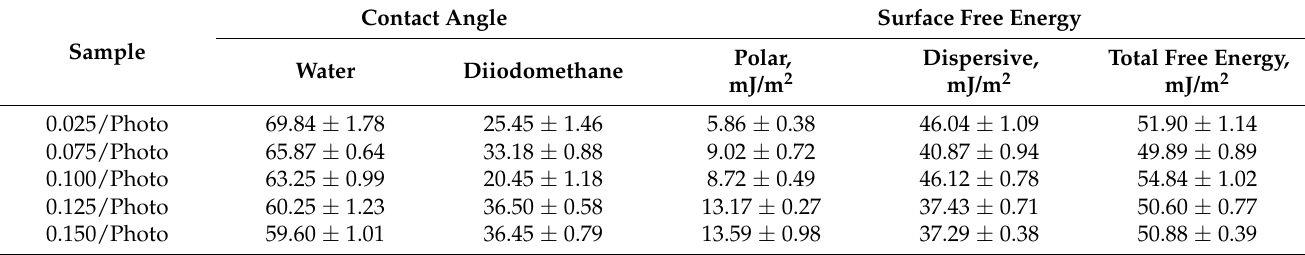
Table 4. Parameters determined during the wettability analysis (given as a mean value ± standard deviation